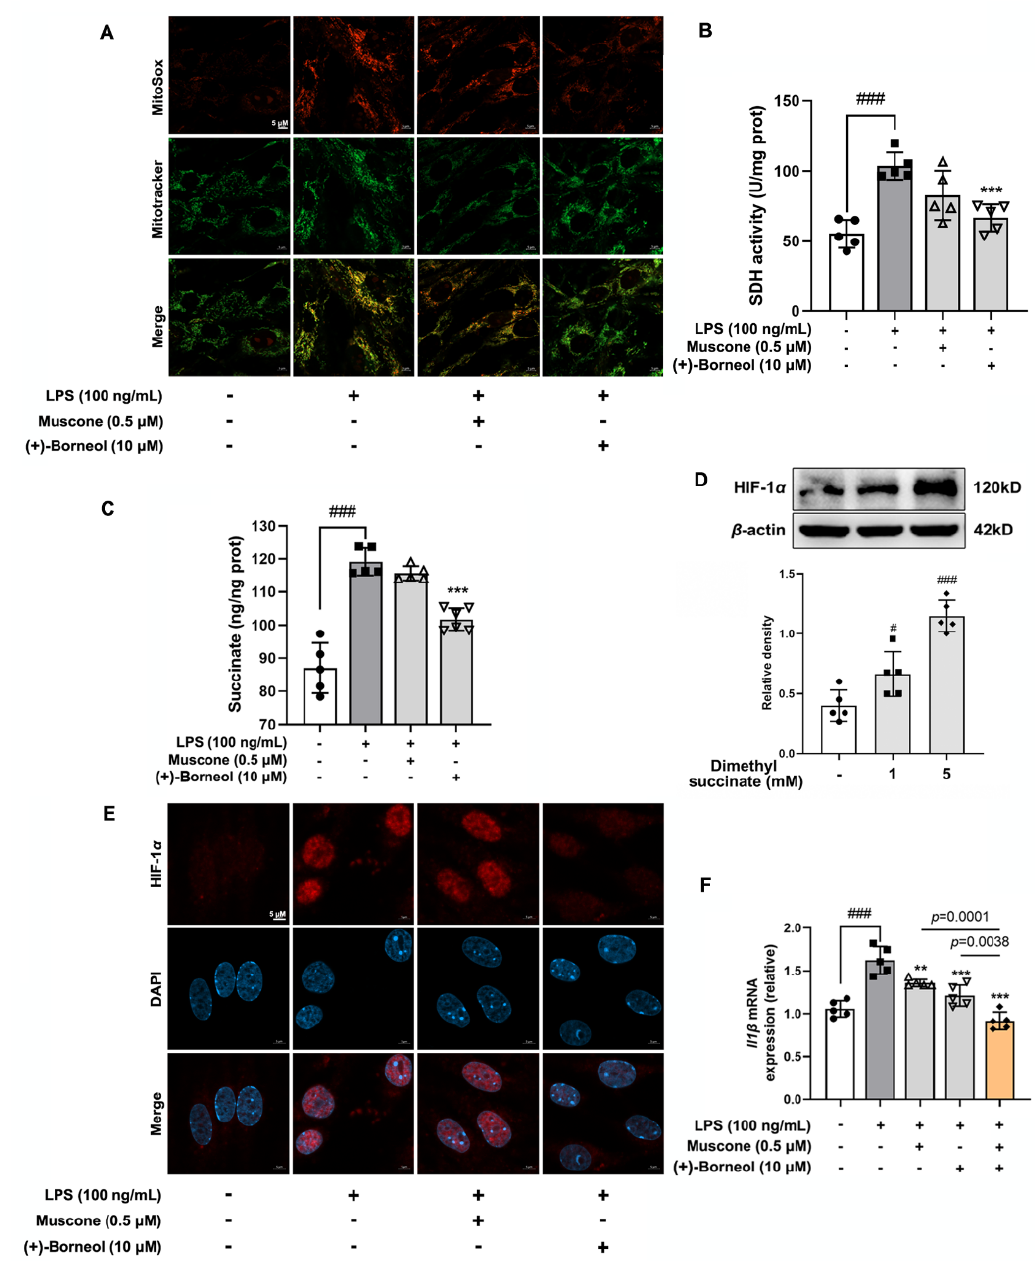
Figure 6. (+)-Borneol suppressed mitochondrial ROS-mediated inflammatory response by inhibiting succinate/Hif-1 α signaling cascades. ( A ) Mitochondrial ROS production was indicated by MitoSox probe staining (red) ( n = 5, scale bar: 5 µ m); ( B ) succinate content was assessed in LPS-stimulated bEnd.3 cells ( n = 5); ( C ) succinate dehydrogenase (SDH) activity ( n = 5); ( D ) protein expression of Hif-1 α in bEnd.3 cells treated with dimethyl succinate ( n = 5); ( E ) Hif-1 α translocation was indicated by immunofluorescence ( n = 5, scale bar: 5 µ m); ( F ) Il1 β mRNA level of bEnd.3 cells treated with LPS ( n = 5). Data are presented as mean ± SD ( n = 5). ** p < 0.01, *** p < 0.001 vs. LPS treatment; # p < 0.05, ### p < 0.001 vs. indicated treatment or untreated group. p values are determined by one-way ANOVA followed by Tukey’s test.